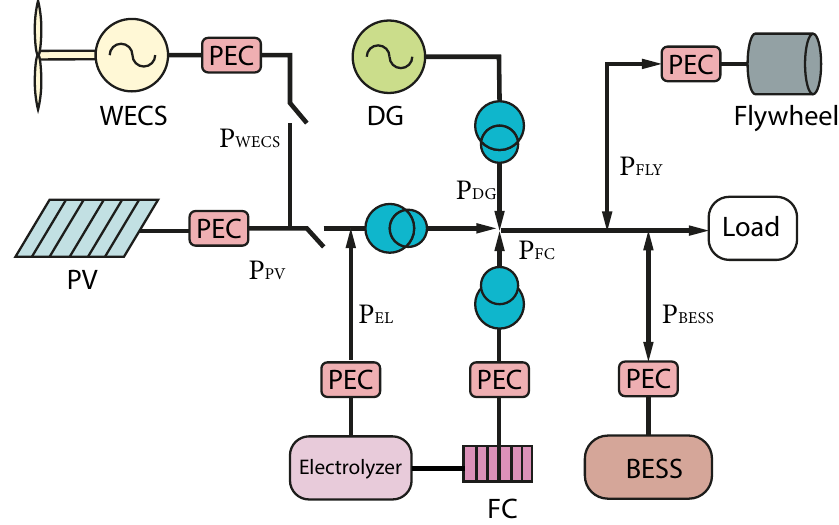
Figure 1. AC/DC hybrid microgrid integrating Renewable Energy Systems generators and AC